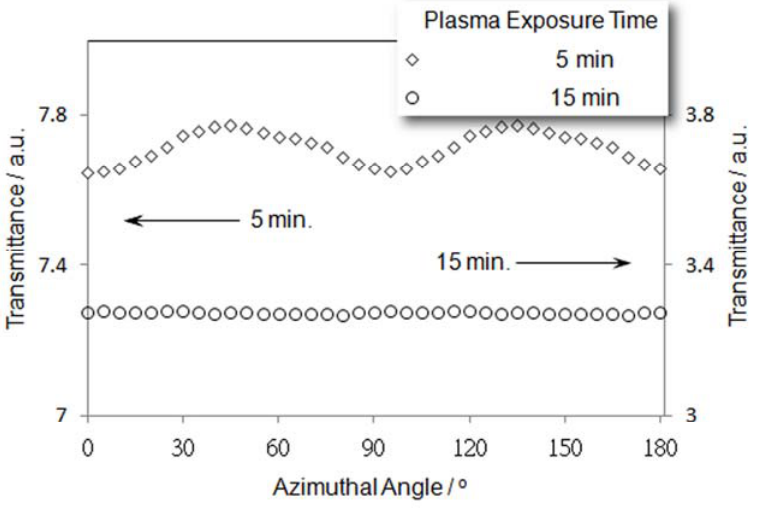
Figure 7. Light transmittance of LC10 layers sandwiched by substrates that were O plasma bombarded for different period. Prolongation of the exposure period of the substrates to the plasma can cause a decrease in light transmittance of the DLC